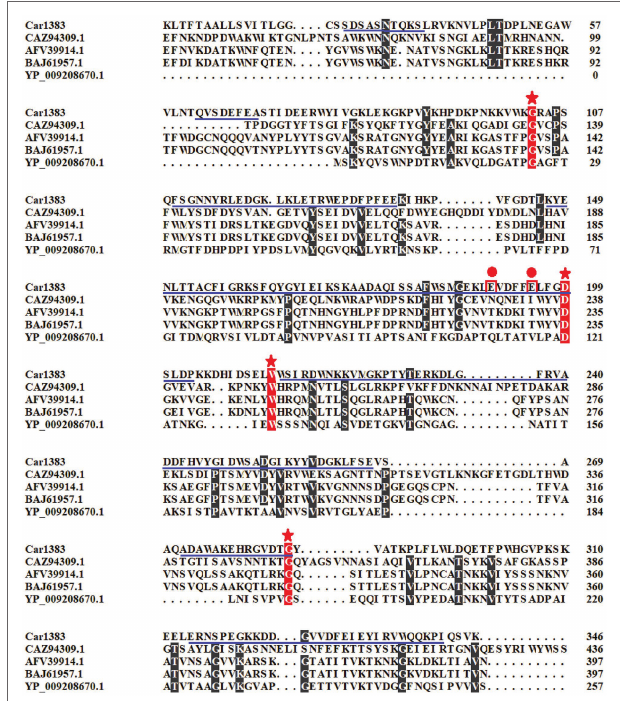
FIGURE 1 | Multiple sequences alignment and motif analysis of Car1383. The conserved sites were indicated with stars. The predictive active residues for Car1383 were indicated with circle dots. The predictive motif of GH16 was highlighted with